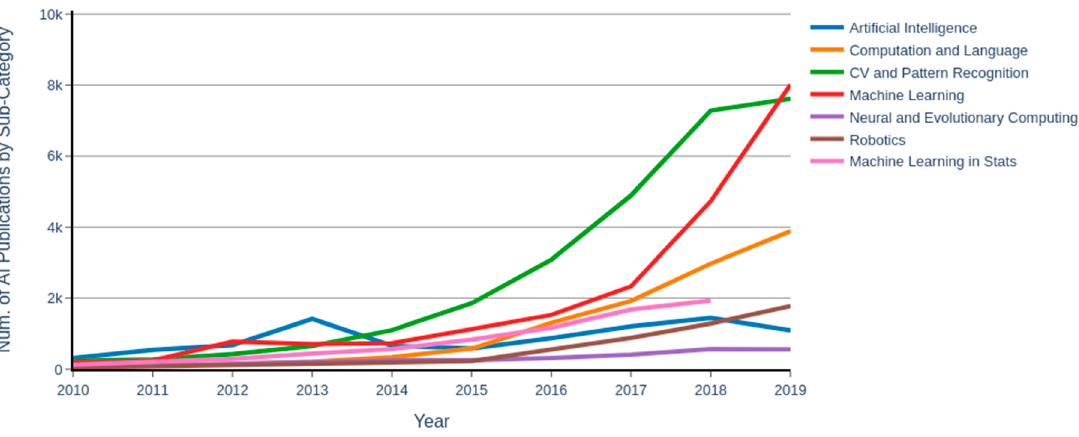
Figure 1. The number of AI papers on ArXiv over time by subcategory from 2010 to 2019. The x -axis of the graph is the year of publication (collected from 2010 to 2019) and the y -axis is the number of the AI papers on ArXiv split by sub-categories of AI research. The data is provided by “2019 AI Index Reports by Stanford” [1].